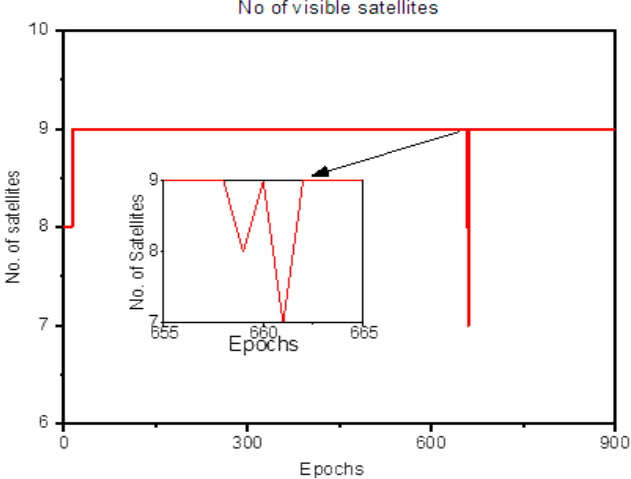
Figure 10. The number of visible satellites for Dataset 2.